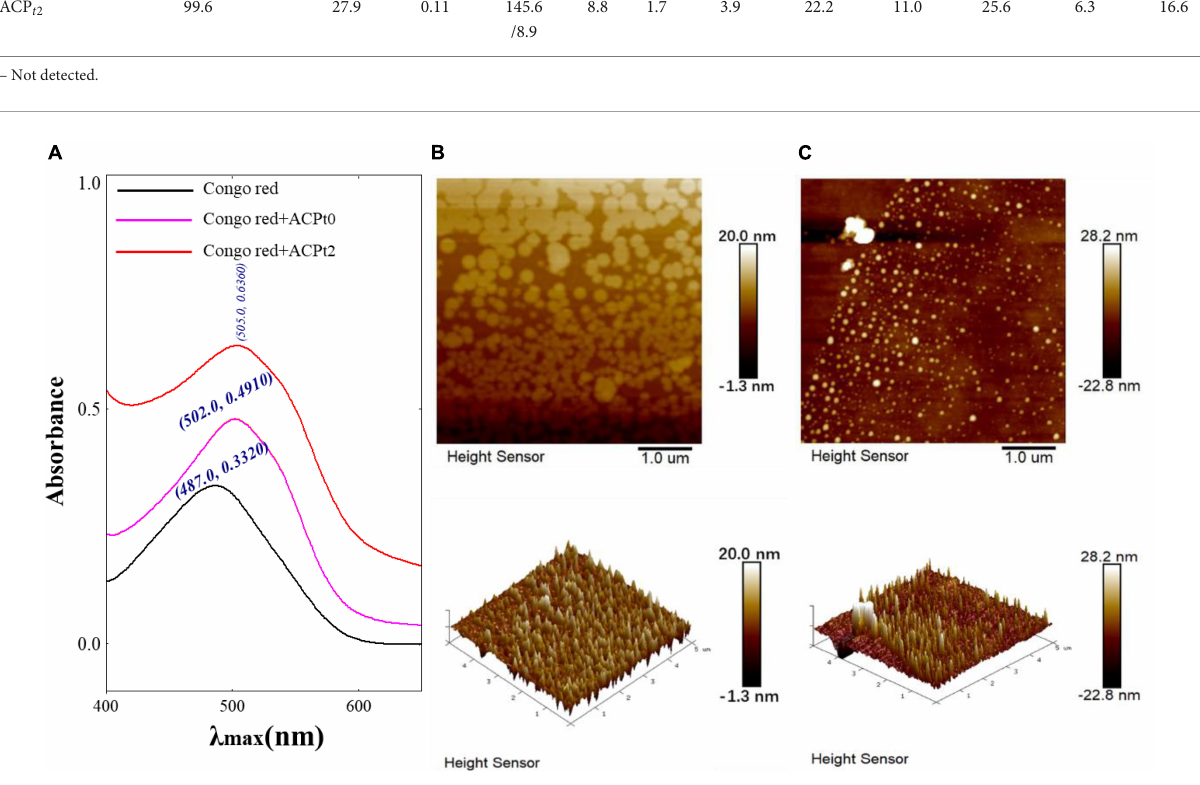
FIGURE3 (A) Maximum absorption wavelength of Congo red + ACP t 0 or ACP t 2 complex and Congo red; AFM spectra of ACP t 0 (B) and ACP t 2 (C) , planar image (upper panels, scan size: 5 µ m), cubic image (lower panel, scan size: 5 µ m).